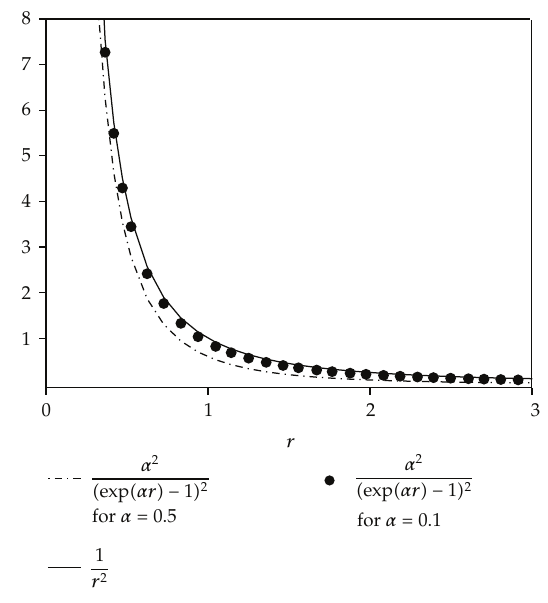
Figure 1: 1 /r 2 and its approximation for di ff erent value of α